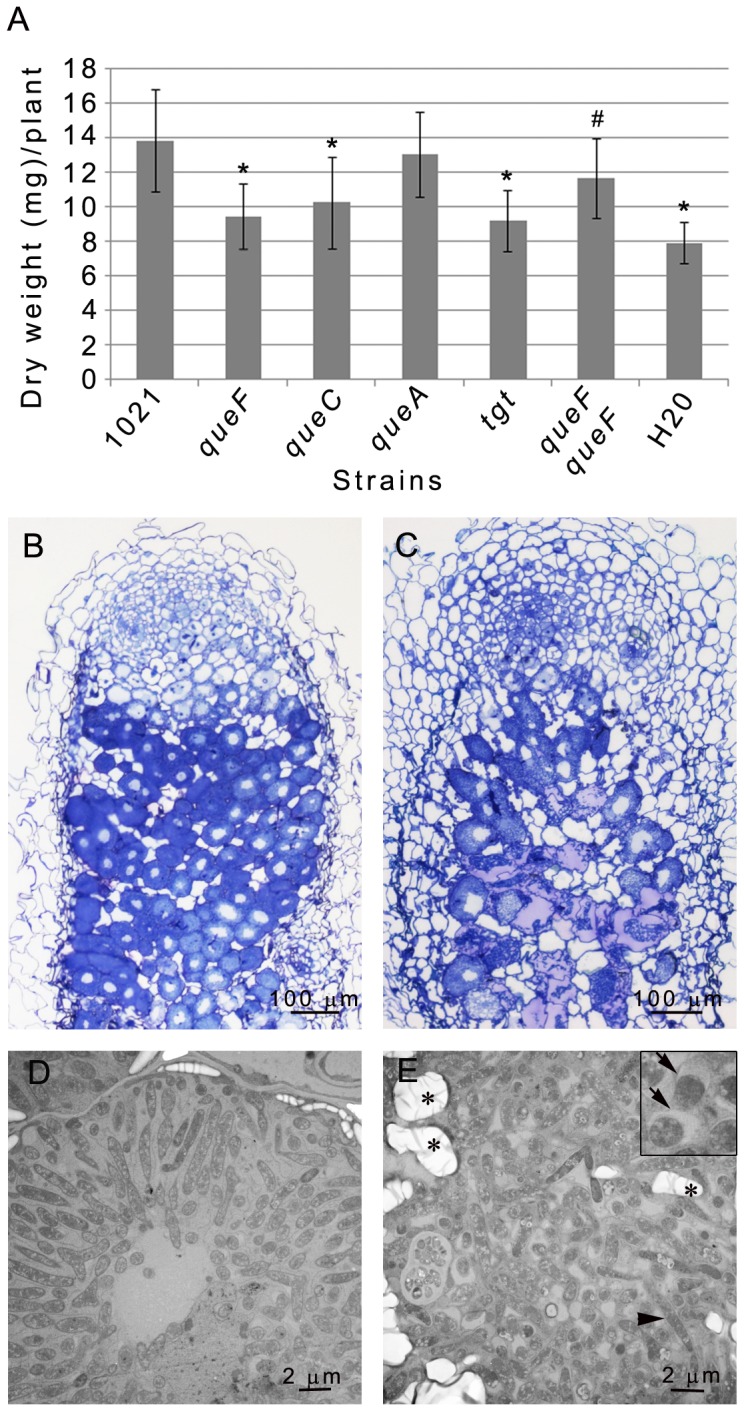
Symbiotic phenotype of S. meliloti queuosine mutants.Dry weight of M. truncatula seedlings inoculated with S. meliloti 1021, different queuosine-deficient mutants and the queF complemented (GMI11186) strain at 40 dpi. Statistical significance (P<0.01) is shown with respect to strain 1021(*) and the queF mutant (#), respectively. (B, C) Sections of M. truncatula 21–day old nodules induced by 1021 (B) and the queF isogenic mutant (C). (D, E) Electron micrographs of nodule cells infected with 1021 (D) or the queF mutant (E). queF mutant bacteroids are randomly organized within the infected cell whereas 1021 bacteroids show a radial organization. (Insert panel in E): arrows point to symbiosome membranes detached from queF bacteria (). Arrowhead, type 4/5 bacteroid. *, starch granules.